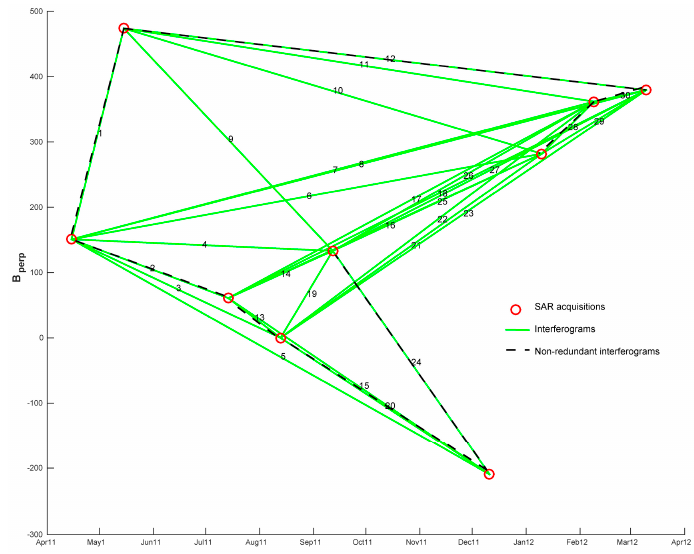
Figure 6. Connection map of the 30 interferograms generated using a spatial baselines (Bperp) below 400 m.